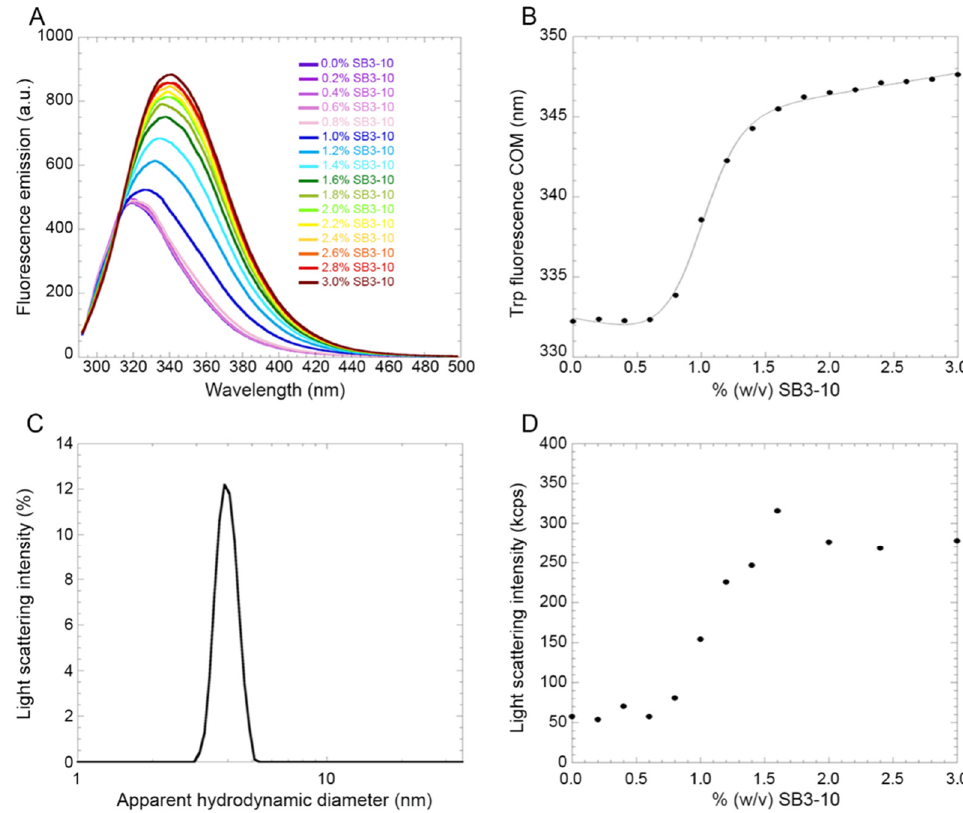
Figure 5. SB3-10-induced denaturation curve of TDP-43 NTD. ( A ) Fluorescence spectra of TDP-43 NTD (excitation 280 nm) at the indicated SB3-10 percentages ( w / v ). ( B ) Plot of spectral COM versus SB3-10 percentage ( w/v ). Data were analysed with a best-fitting procedure using the two-state model equation [31]. ( C) Representative DLS distribution of a solution containing 3.0% ( w/v ) SB3-10 in the absence of protein. Similar distributions were obtained at all SB3-10 percentages analysed here, using a fixed attenuator and measurement position on the instrument. ( D ) Plot of light scattering intensity as a function of the SB3-10 percentage ( w/v ) in the absence of protein, using a fixed attenuator and measurement position on the instrument.